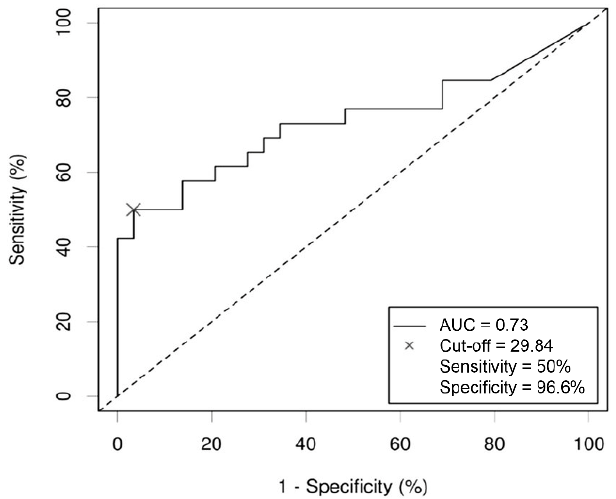
Figure 4. Receiver operating characteristic (ROC) curve for all-cause mortality for sST2 in stable COPD. The prognostic utility of circulating sST2 for outcome in patients with stable COPD. sST2 predicted all-cause mortality with 96.6% specificity and 50% sensitivity and an area under the curve (AUC) of 0.73. Optimal cut-off value for sST2 was calculated and circulating sST2 was measured as described in Methods section. Table 4. sST2 adds prognostic information on top of clinical risk factors in patients with COPD.